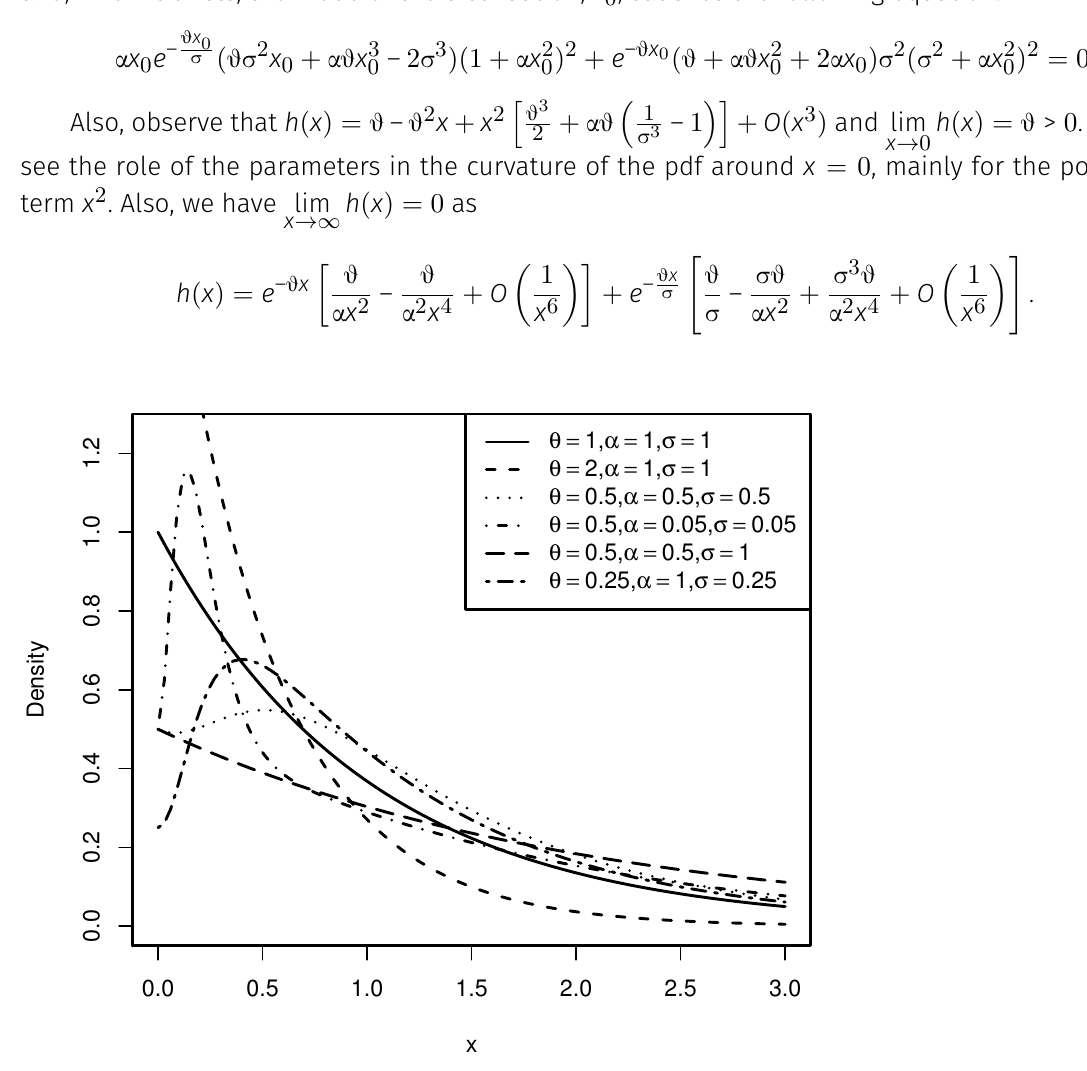
Figure 1. Various shapes of the pdf of the FWE